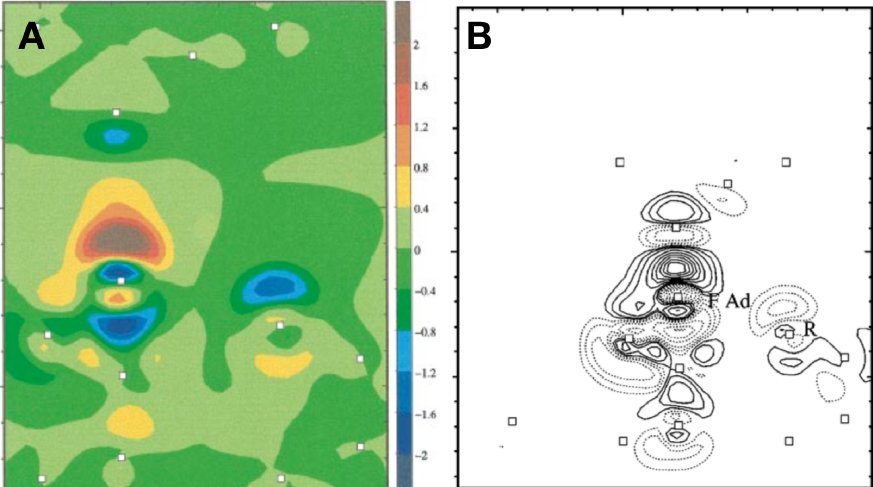
Figure 5. DFT calculations of covalent bond formation between a Si tip and Si surface atoms. ( A ) Charge density difference between the self- consistent electron density of the interacting system and the superposition of the densities of the isolated tip and the clean surface. The plot corresponds to a plane perpendicular to the surface along the long diagonal (only part of the unfaulted half of the unit cell is shown). The tip is on top of the adatom on the long diagonal in the faulted half of the unit cell (the point of maximum bonding energy and normal force in Figure 1). The squares indicate the position of the atoms in that plane both in the tip and in the Si surface. The contours are in units of 10 − 2 electrons/Å 3 . Notice the transfer of charge to the adatom dangling bond from the backbond and the dangling bond in the rest atom. ( B ) Charge-density difference between the self-consistent electronic density of the interacting system and the superposition of the densities of the isolated tip and surface. The plot is taken on a plane perpendicular to the surface along the long diagonal in the faulted half of the unit cell. The tip is on top of the adatom in the faulted half. The tip-surface distance is 3.5 Å. The squares indicate the position of the Si atoms in that plane both in the tip and in the Si surface. The solid (dotted) lines indicate an increase (decrease) of electronic charge; the contours correspond to ± 0.4, ± 1, ± 2 (as in Figure 2 in reference [35]), ± 4, ± 6, ± 8, ± 10, ± 12, ± 14 and ± 16 × 10 − 2 electrons/Å 3 . Notice the transfer of charge to the adatom dangling bond from the backbond and the dangling bond in the restatom in the faulted half. Adapted with permission from American Physical Society from Figure 2 in [35] (A) and Figure 6 in [36]